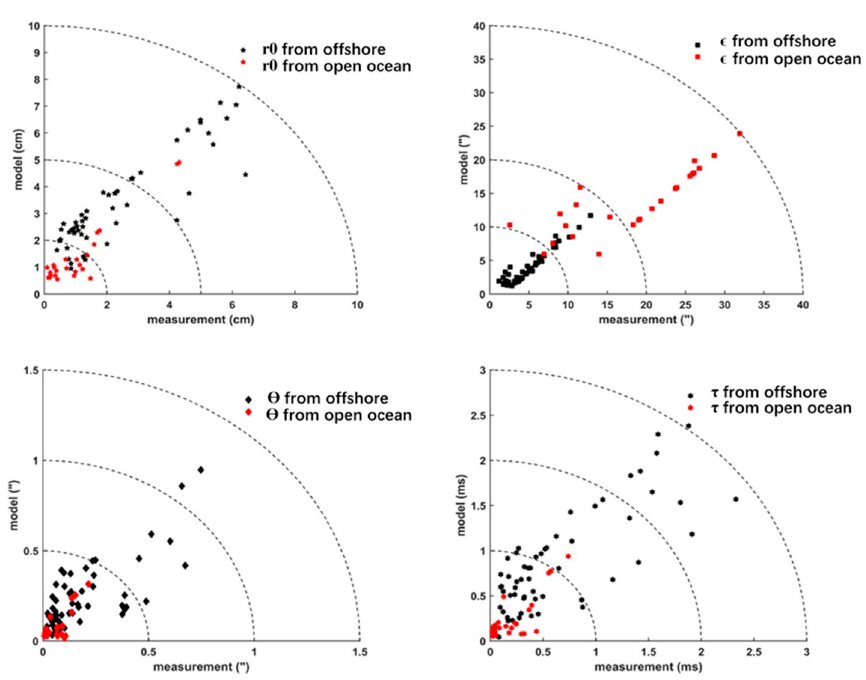
τ ) derived from 2 0